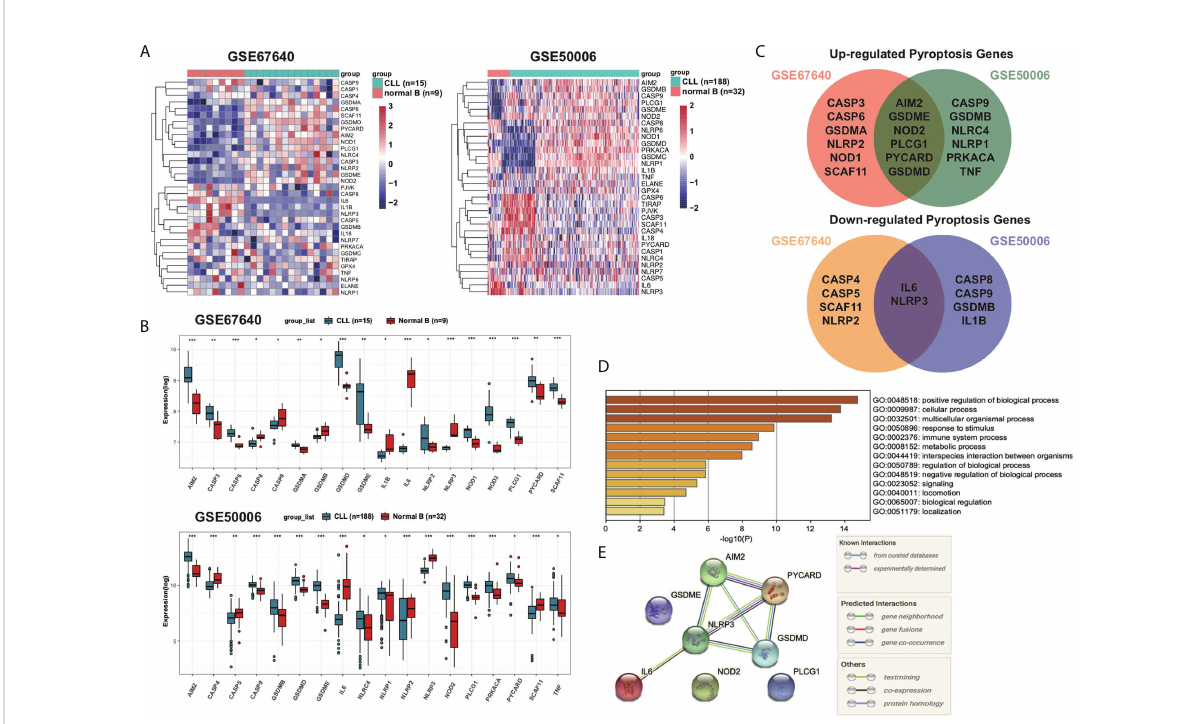
FIGURE 2 Overview of differentially expressed pyroptosis-related signatures in CLL. (A) Expression pro fi les of PRGs in CD19+ CLL and normal B cells in GEO: GSE67640 and GSE50006. Genes were clustered according to their expression. Red color represents high expression and blue color represents low expression. (B) Differentially expressed PRGs between CD19+ CLL and normal B cells. Adjusted p -values were shown as *adjusted p < 0.05; **adjusted p < 0.01; ***adjusted p < 0.001. (C) Venn of upregulated PRGs in both GSE67640 and GSE50006, and of downregulated PRGs in both GSE67640 and GSE50006. (D) GO analysis of differentially expressed PRGs based on the Metascape online. (E) PPI network showed the hub genes in the pyroptosis gene